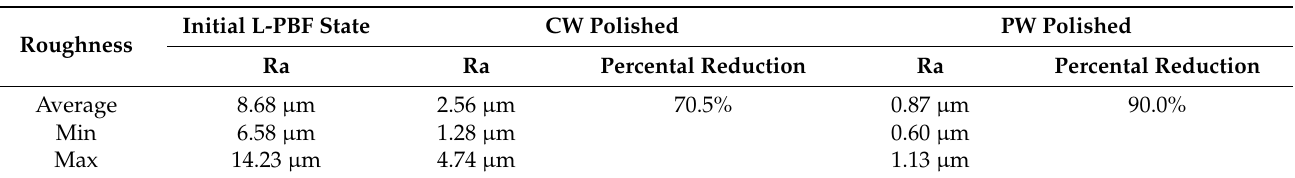
Table 4. Roughness improvement by laser polishing with continuous (CW) and pulsed laser radiation (PW).